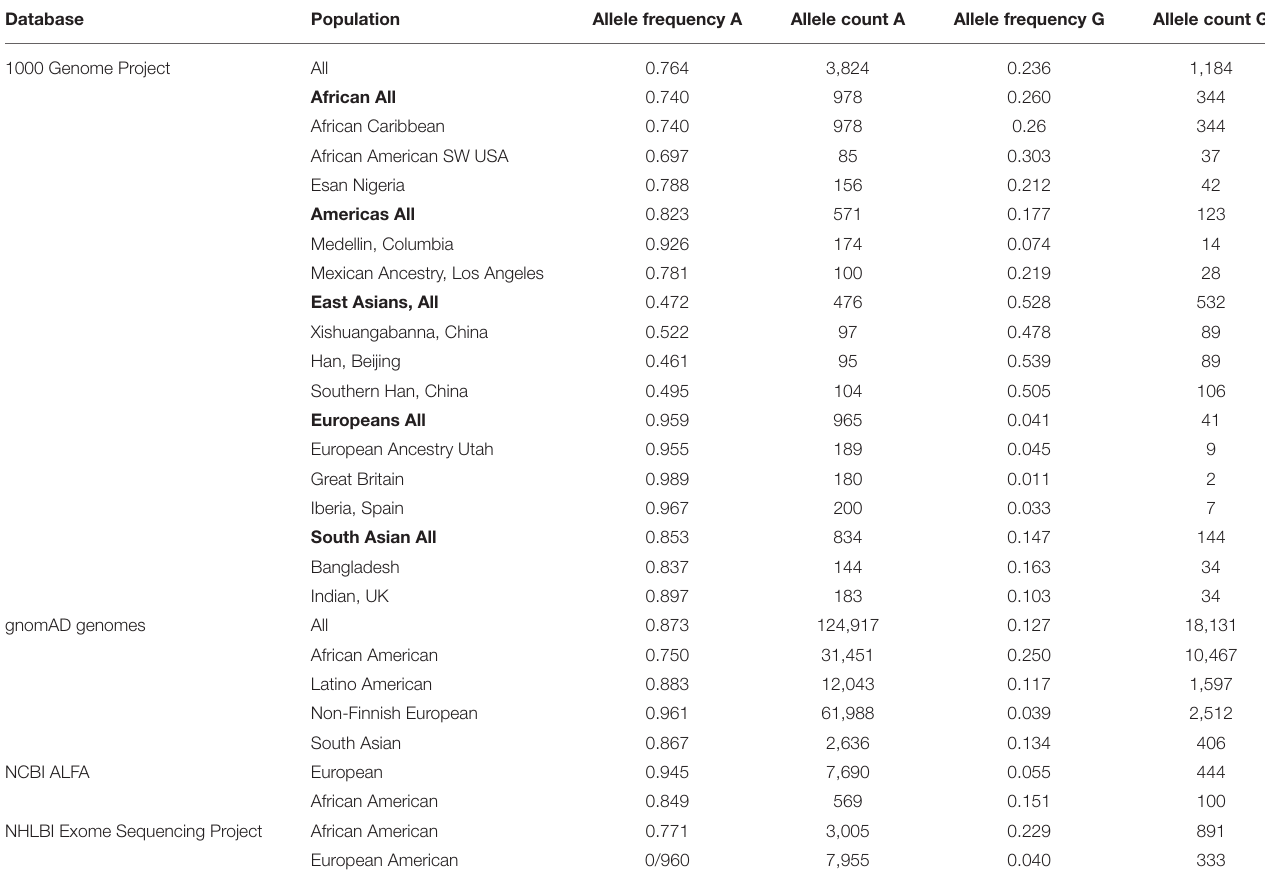
TABLE 1 | Allele Frequency of the IFITM-rs12252 alleles among various populations. Database Population Allele frequency A Allele count A Allele frequency G Allele count